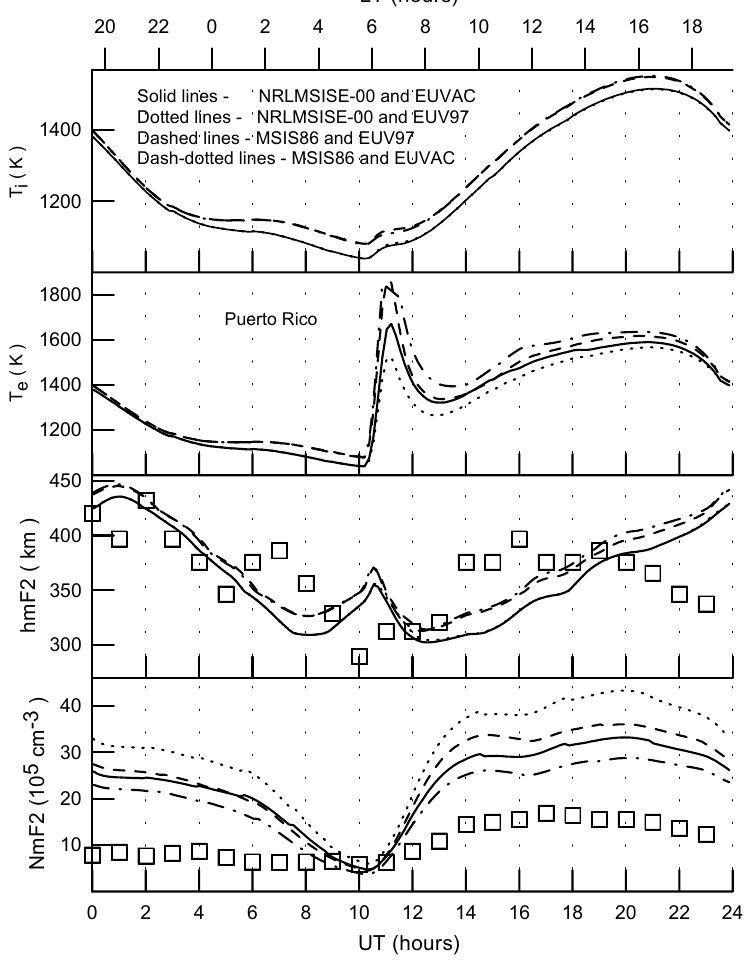
Fig. 8. From bottom to top, ob- served (squares) and calculated (lines) of Nm F2, hm F2, electron temperatures and O + ion temperatures at the F2- region main peak altitude above the Puerto Rico ionosonde station on 7 Oc- tober 1957. LT is the local time at the Puerto Rico ionosonde station. The curves are the same as in Fig.